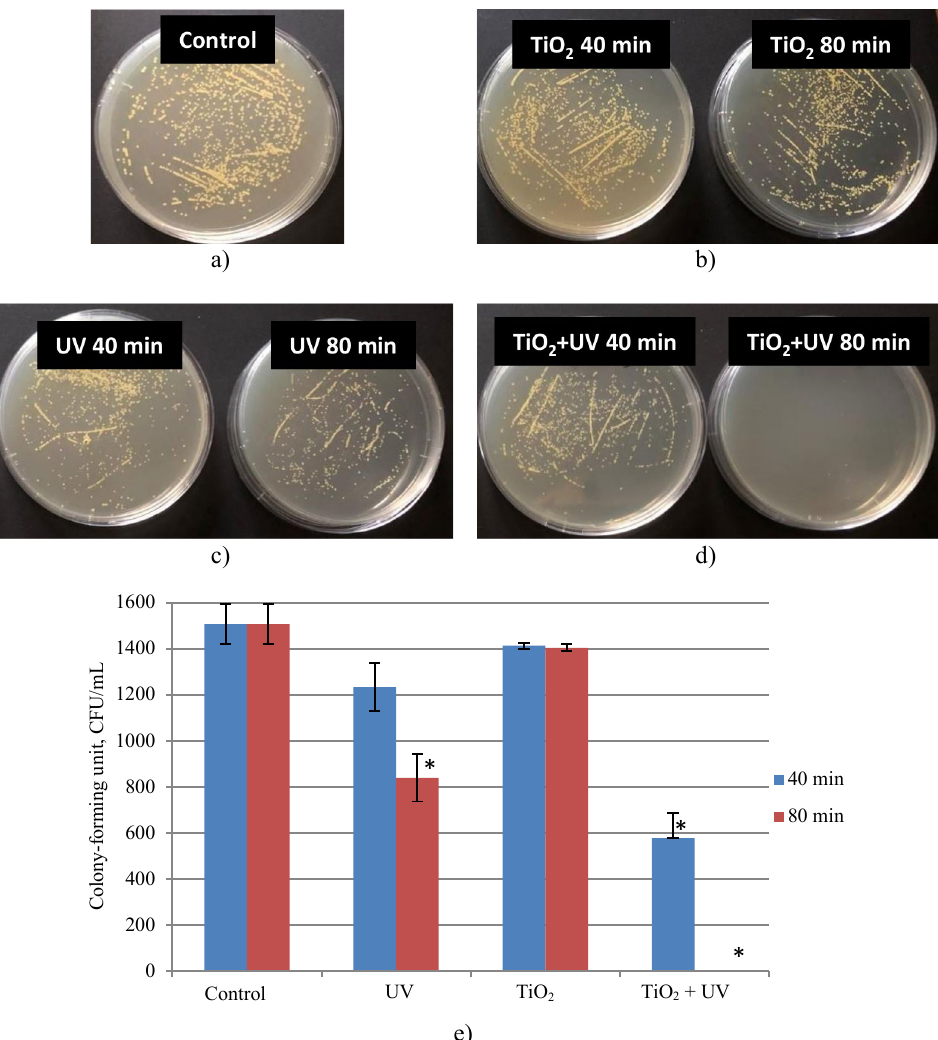
Fig. 5 Viability of M. luteus cells determined by SP method ( n = 3): a) Negative control with none-irradiated cells; b) effect of TiO 2 ; c) effect of UV; d) effect of TiO 2 + UV. The experiments were performed at 22 °C, the initial amount of bacteria was 2.7×10 6 cfu/mL, dilution factor 1000. 1 mg/mL of TiO 2 was used and the intensity of UV irradiation was 2 mW/cm 2 . *statistically significant difference compared to control group, using one-way ANOVA, p <